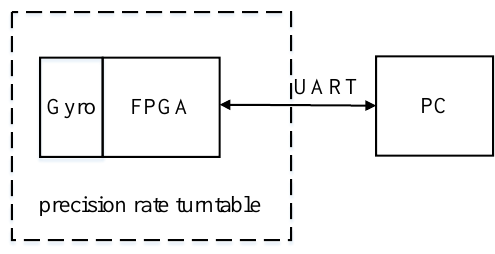
Figure 14. Test platform.